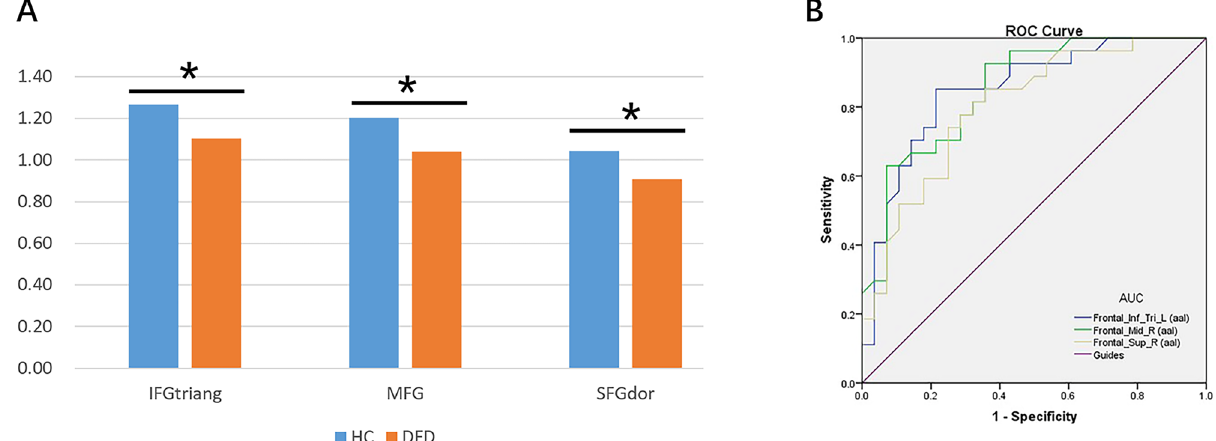
Figure 3. ( A ) The average ReHo value of DE and HCs. IFGtriang: Inferior frontal gyrus triangularpart; MFG: Middle frontal gyrus; SFGdor: Superior frontal gyrus dorsolateral. ( B ) ROC Analysis of ReHo Value of DE. Inf_Tri_L Inferior frontal gyrus triangularpart, Mid_R Middle frontal gyrus, Sup_R Superior frontal gyrus dorsolateral, ROC Receiver operating characteristic curve, AUC Area Under